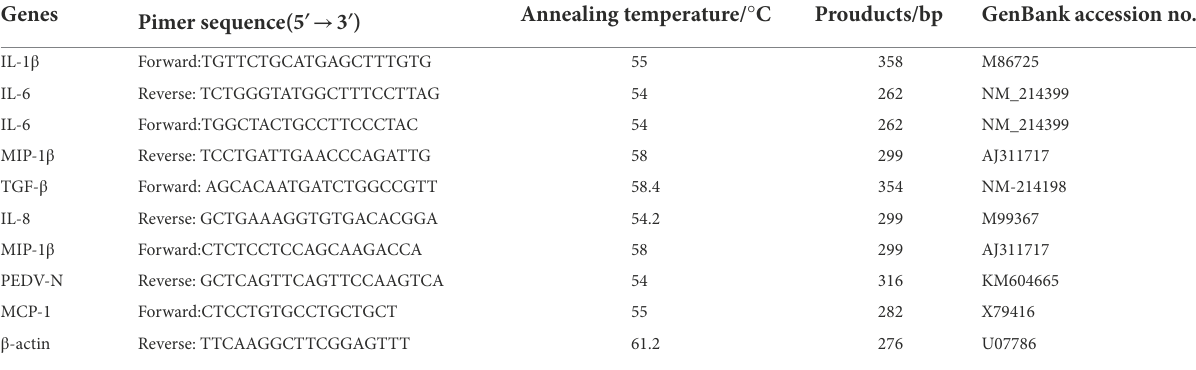
TABLE 1 Conditions and primers of PCR to amplify genes of